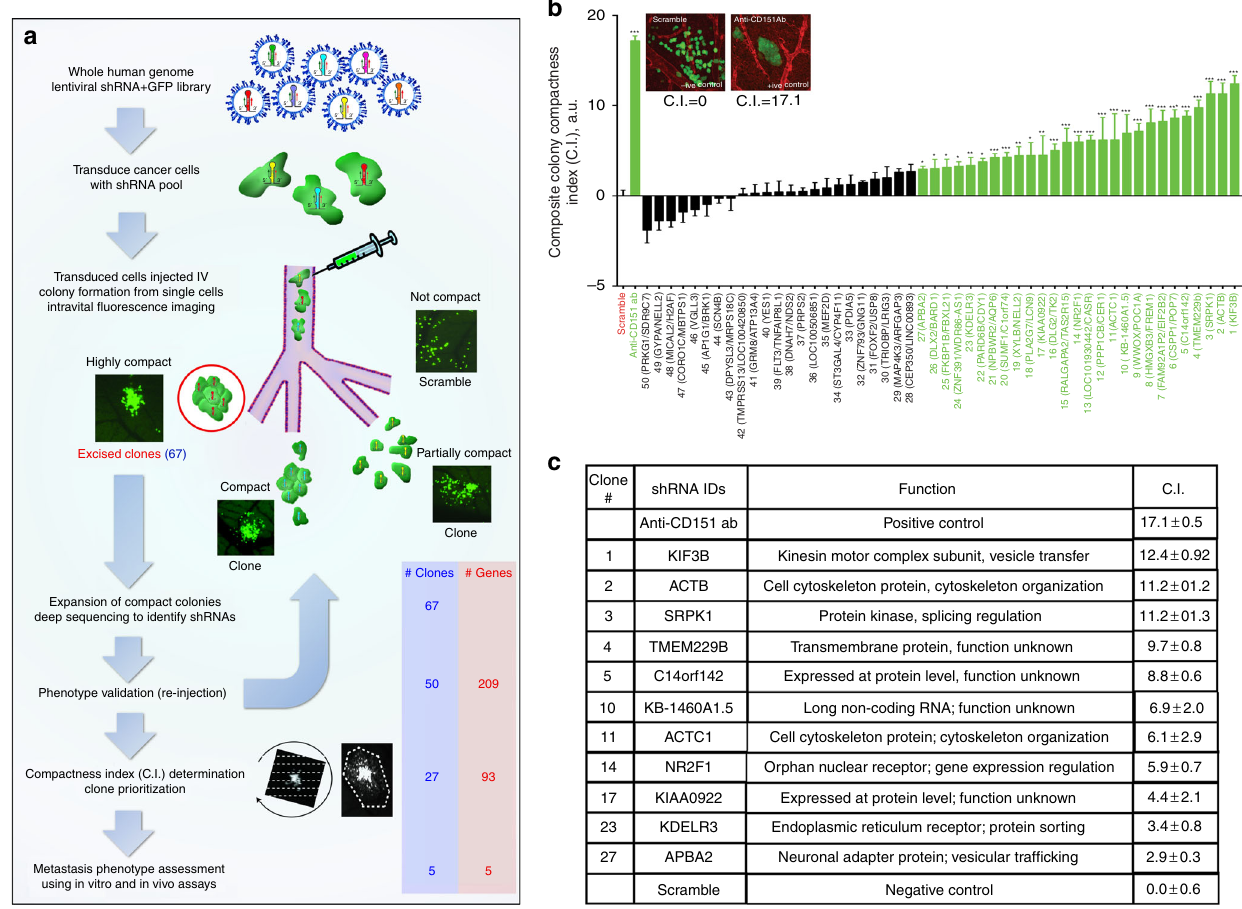
Fig. 1 Overview of the in vivo screen for genes required for productive motility. a HEp3 cells were transduced with a pooled whole human genome lentiviral shRNA library and injected intravenously into 100 ex ovo avian embryos. Compact metastatic colonies derived from single cancer cells were excised 6 days post injection, expanded and analyzed by Illumina deep sequencing. Colonies were re-injected individually to validate their phenotype and prioritized based on a composite compactness (C.I.) index. Selected screen hits that produced metastatic colonies that were signi fi cantly more compact than those produced by cancer cells transduced with scramble shRNA transduced cells were selected for further analysis. b Composite compactness index (C.I.) distribution of screen hits relative to positive (anti-CD151) and negative (scramble shRNA) controls. Screen hits that are signi fi cantly more compact than negative control are indicated in green. Clones containing a single shRNA species are in bold. For clones containing multiple shRNAs, the two most predominant shRNAs are shown. Statistical signi fi cance was determined using one-way ANOVA with Fisher ’ s LSD test (* p < 0.05, ** p < 0.01, *** p < 0.001). c Table summarizing shRNA gene IDs from signi fi cantly compact clones containing single shRNA. Gene cards (http://www.genecards.org) and KEGG pathway (http://www.genome.jp) databases were used for gene function